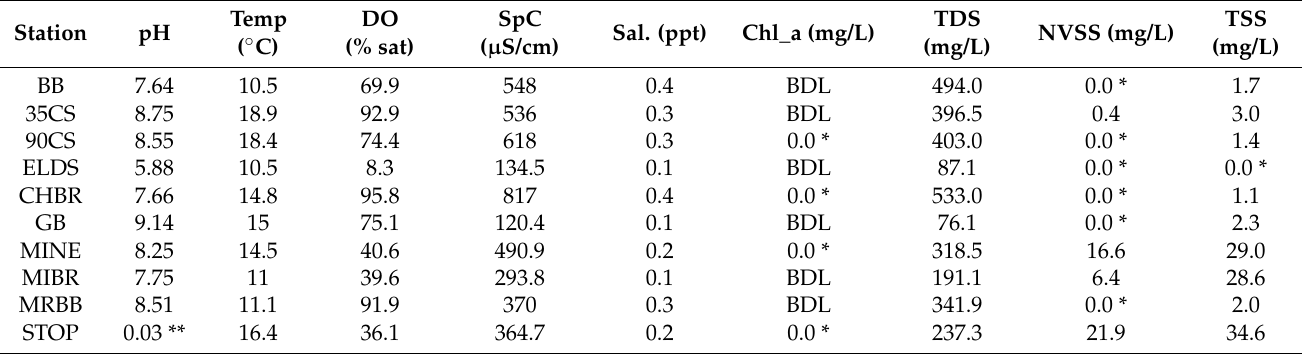
Table 2. Physical–chemical properties of 10 sample stations within the Charles River watershed sampled in 2012.